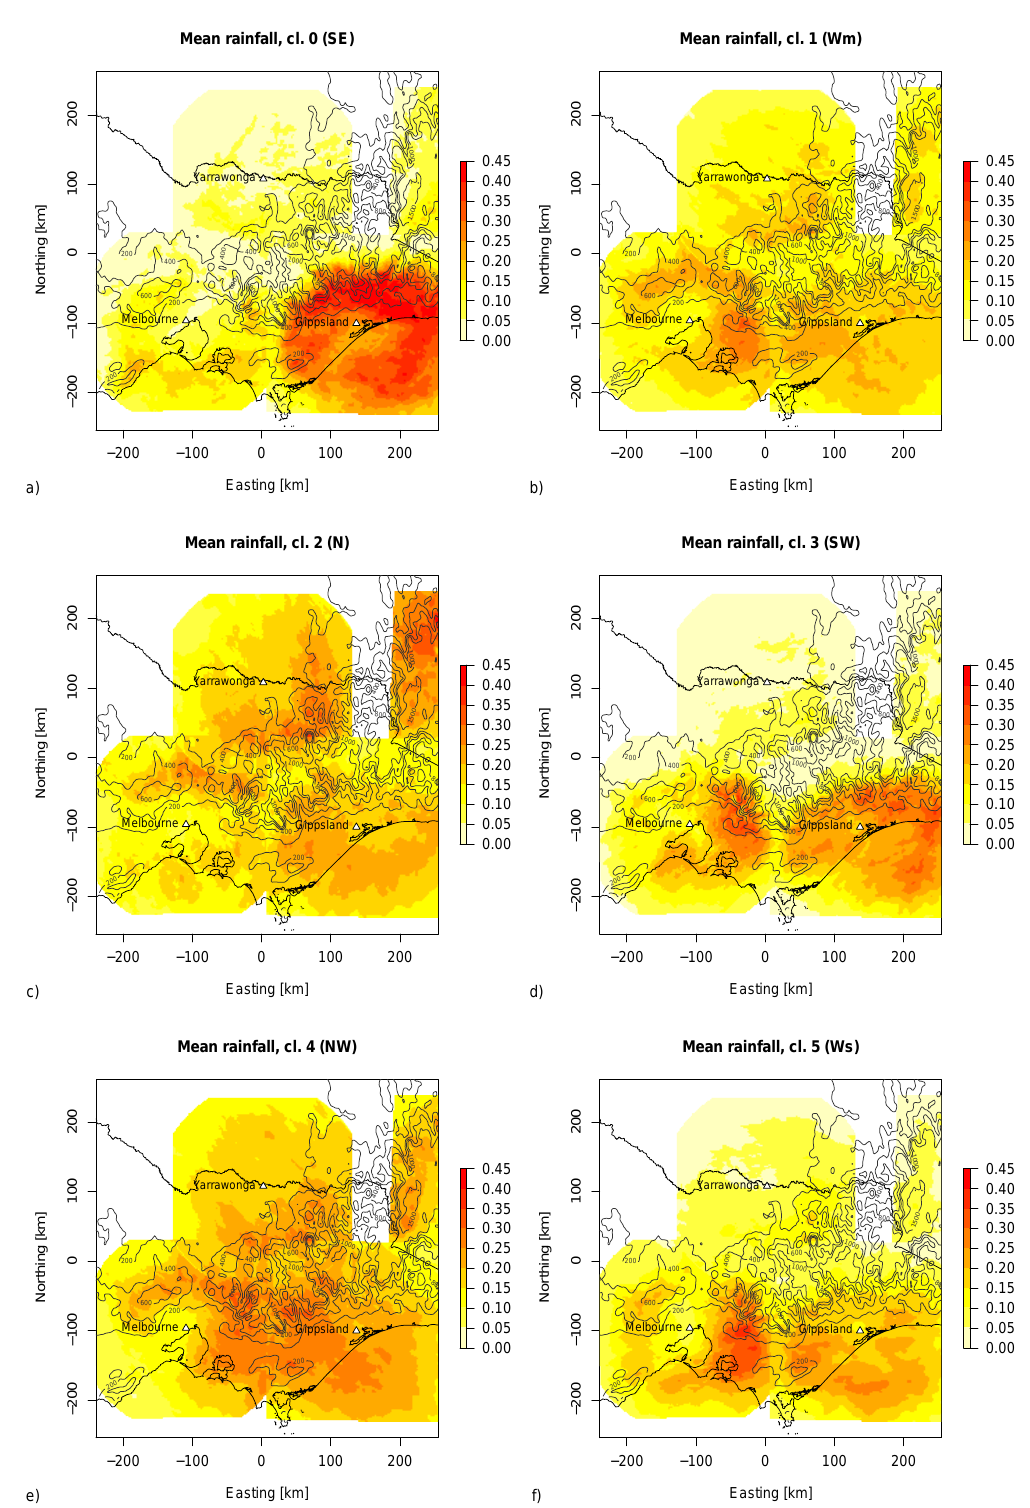
Figure 6. Conditional mean 10min rainfall accumulations for flow regimes (a) SE, (b) Wm, (c) N, (d) SW, (e) NW and (f) Ws.